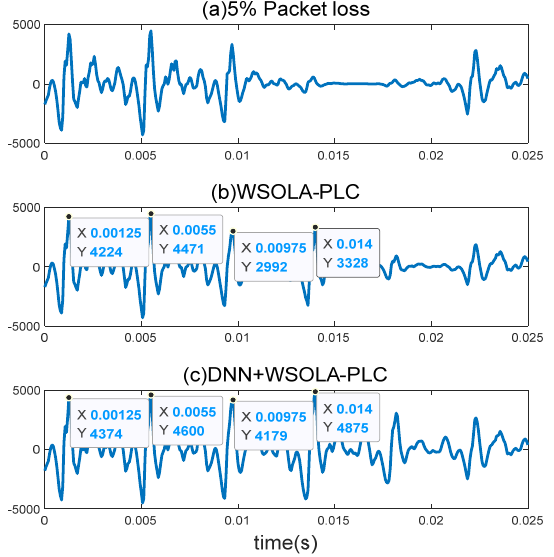
Figure 10. Waveform comparison: ( a ) 5% packet loss; ( b ) WSOLA − PLC; ( c ) DNN+WSOLA − PLC.